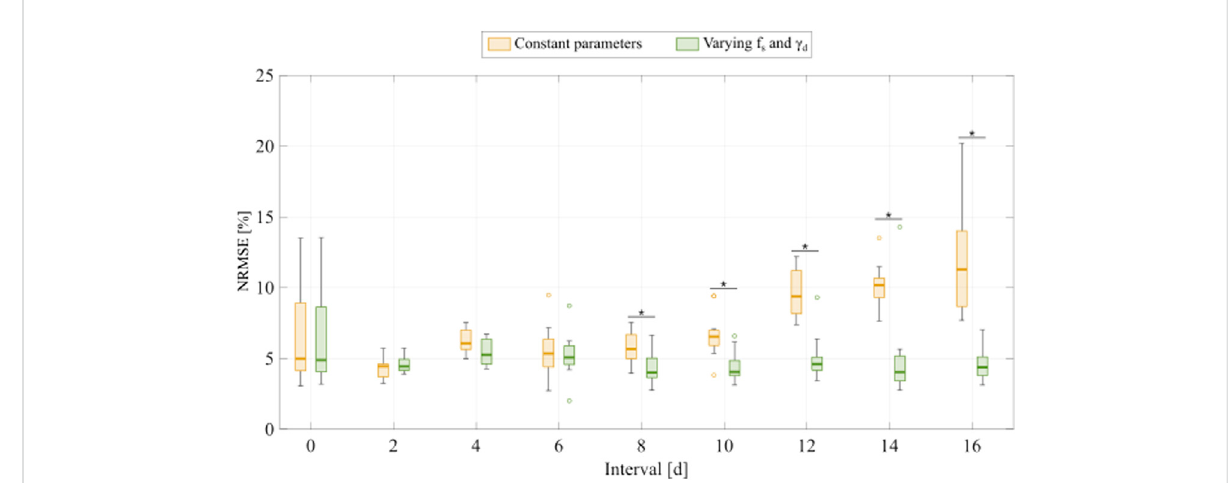
FIGURE 5 Comparison of fi tting the experimental data for varying inter-treatment intervals with the multiple-dose model with constant versus varying parameters. For each inter-treatment interval tested in Experiment 2 (Table 1), we compared the normalized root mean squared error (NRMSE) calculated from the fi ttings using the multiple-dose model with constant parameters (yellow boxplots) with the NRMSE calculated from the fi ttings usingthemultiple-dosemodelwithvarying f s and γ d (greenboxplots).Outliersarerepresentedwithcircles.Atinter-treatmentintervalsof8,10, 12, 14, and 16 days, there is a signi fi cantly lower NRMSE when the model with varying f s and γ d is used (p: 0.0061, 0.0017, 1.56× 10 − 4 , 5.92× 10 − 4 , 3.66 × 10 − 5 , respectively). An asterisk (*) indicates p < 0.05 (two-sided Wilcoxon rank sum